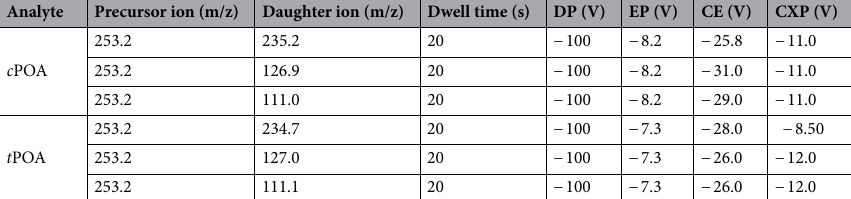
Table 1. Electrospray ionization ESI-MS/MS parameters for c POA and t POA.